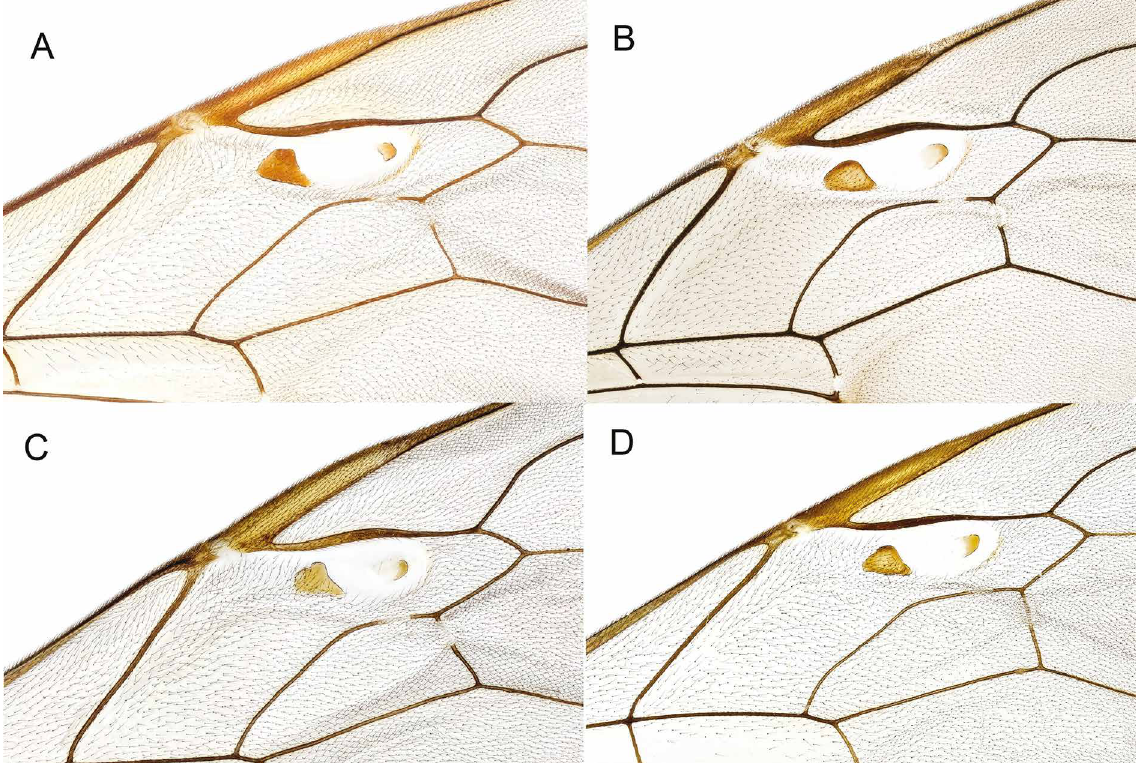
Fig. 4. Central part of fore wing. A . Enicospilus combustus (Gravenhorst, 1829), ♀. B . E. cederbergi sp. nov., paratype, ♀ (NHRS-HEVA000008146). C . E. ryrholmi sp. nov., paratype, ♀ (NHRS- HEVA000008173). D . E. adustus (Haller, 1885),